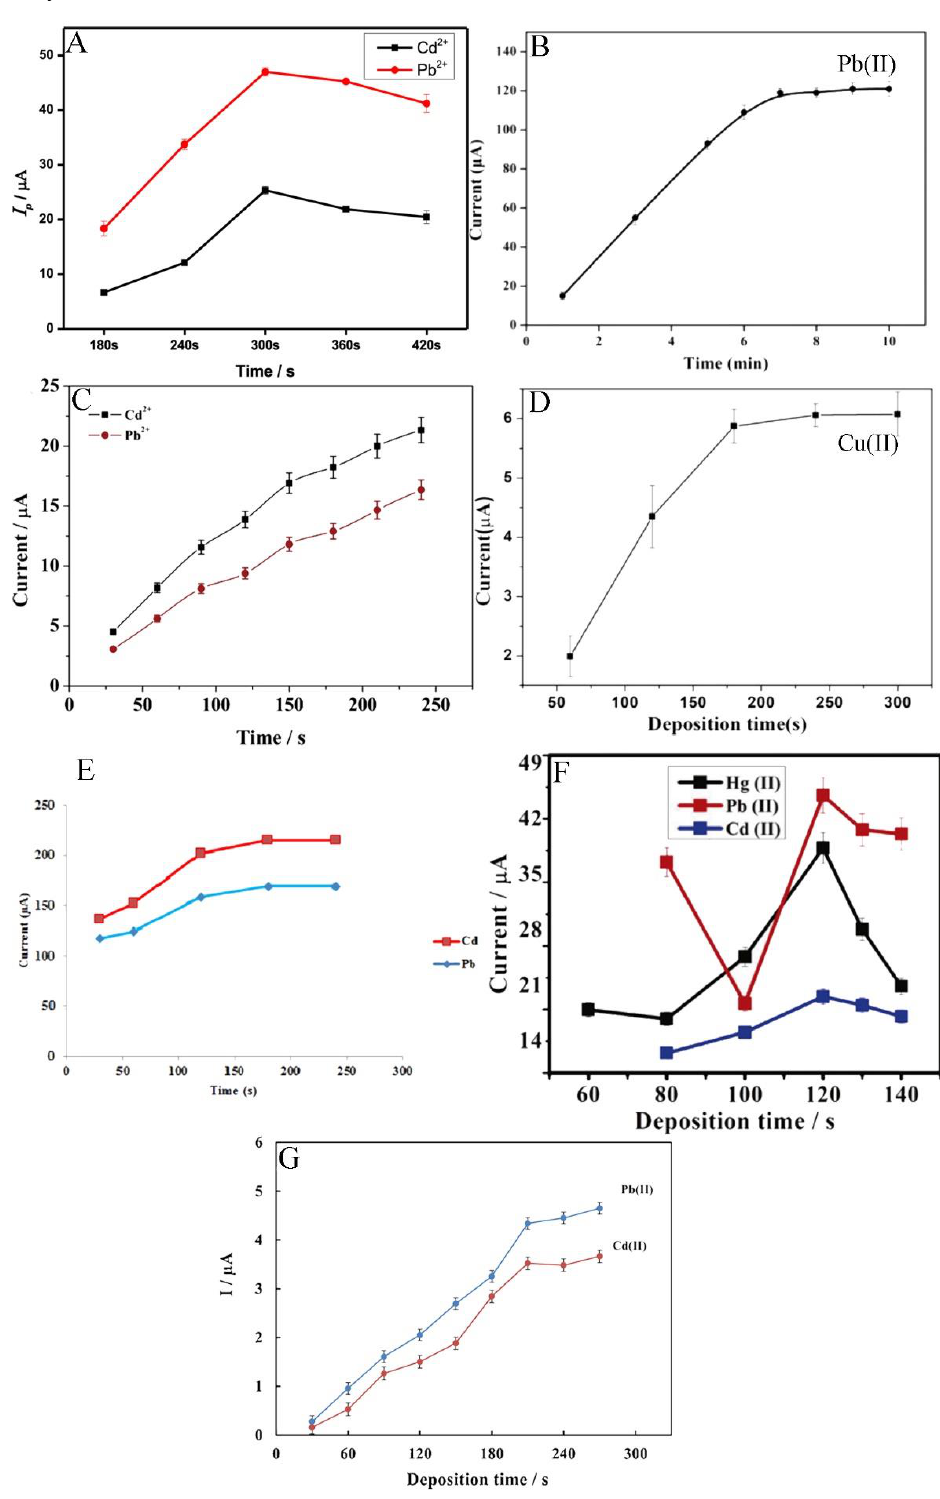
Figure 5. Optimisation of deposition time of different ions such as Cd 2+ , Pb 2+ , and Hg 2+ determination by electrochemical methods presented by Pu et al. [61] ( A ), Wang et al. [60] ( B ), Xu et al. [63] ( C ), Wei et al. [55] ( D ), Dahaghin et al. [66] ( E ), Deshmukh et al. [68] ( F ), and Baghayeri et al. [69] ( G ). All Figures are adapted from references [55, 60, 61, 63, 66, 68, 69] with permission from Elsevier.